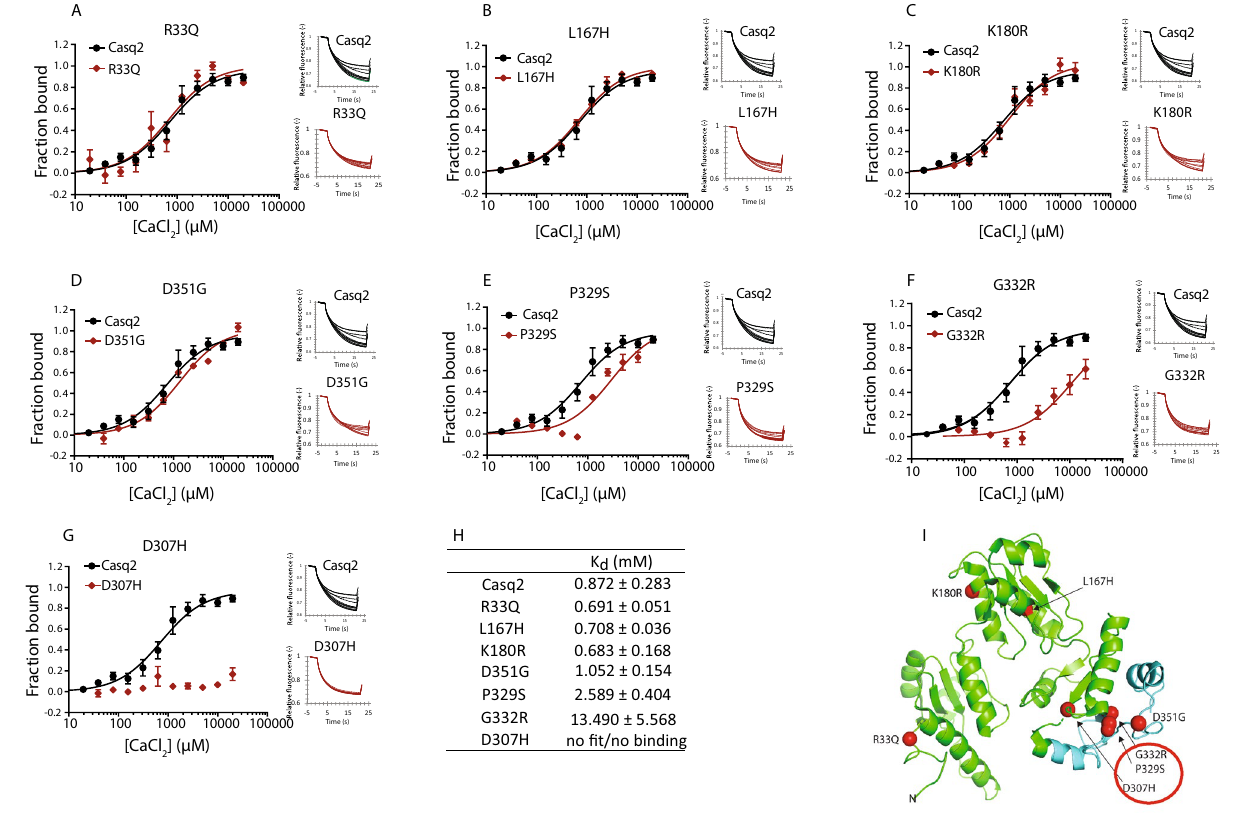
Figure 3. Calcium binding to calsequestrin mutants. ( A – G ) MST analysis of Ca 2+ binding to mutants Casq2 (red line) and wild-type Casq2 (black line). ( H ) Calculated Ca 2+ binding affinities of Casq2 mutants. ( I ) 3D structure of human Casq2 (adapted from 2VAF) with the location of mutants indicated in the Figure. The red circle depicts the location of mutations that affected Ca2 binding to